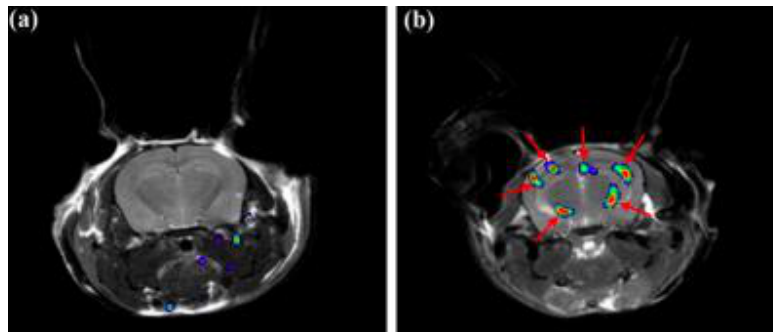
Figure 2. 19F MRI signals of bovine serum albumin@F-functionalized graphene quantum dots (BSA@FGQDs) in normal ( a ) and Alzheimer’s disease (AD) ( b ) mice overlaid on top of a high-resolution T1-weighted proton MRI image [27]. Arrows indicate the detection of in vivo amyloid plaques. Images are reprinted with permission from the publisher [27].